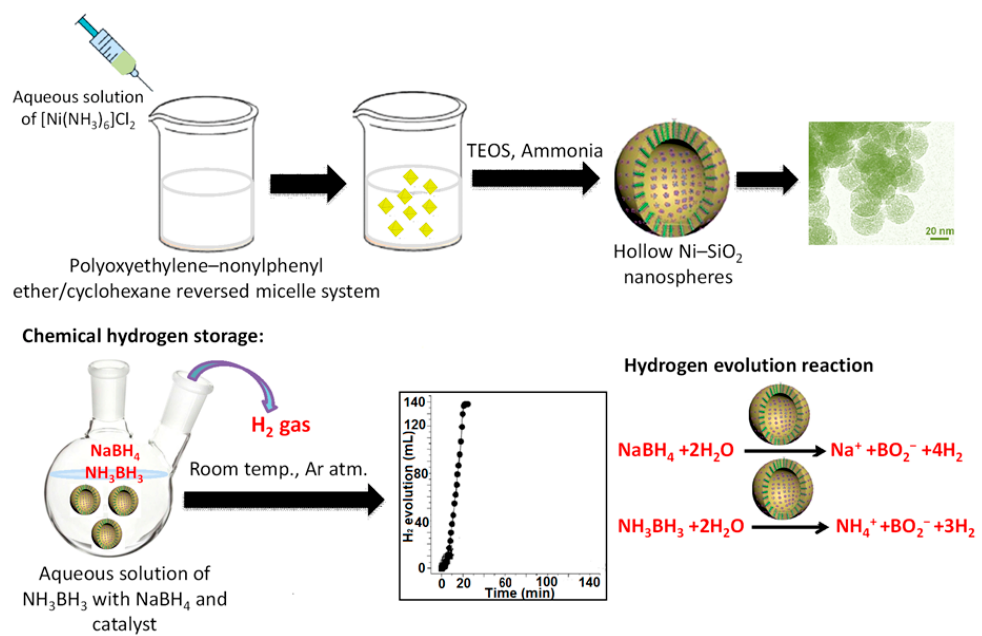
Figure 15. A schematic representation of catalytic hydrogen storage process over hollow Ni-SiO 2 nanosphere.